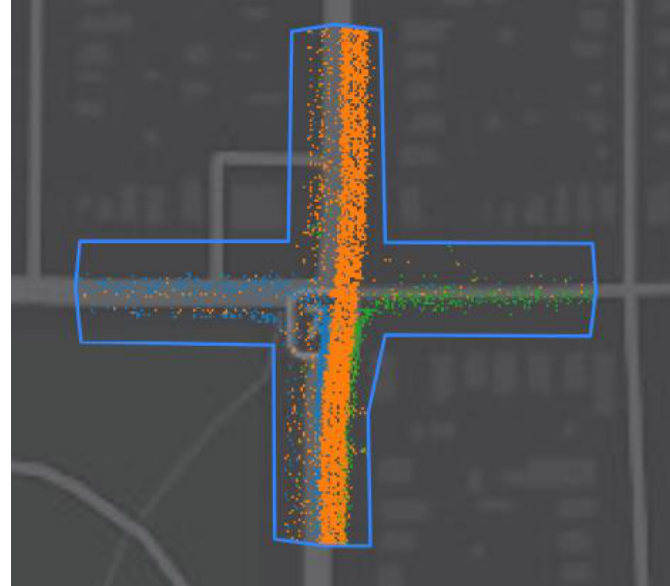
Figure 4. Turning Movement from DB4IoT.